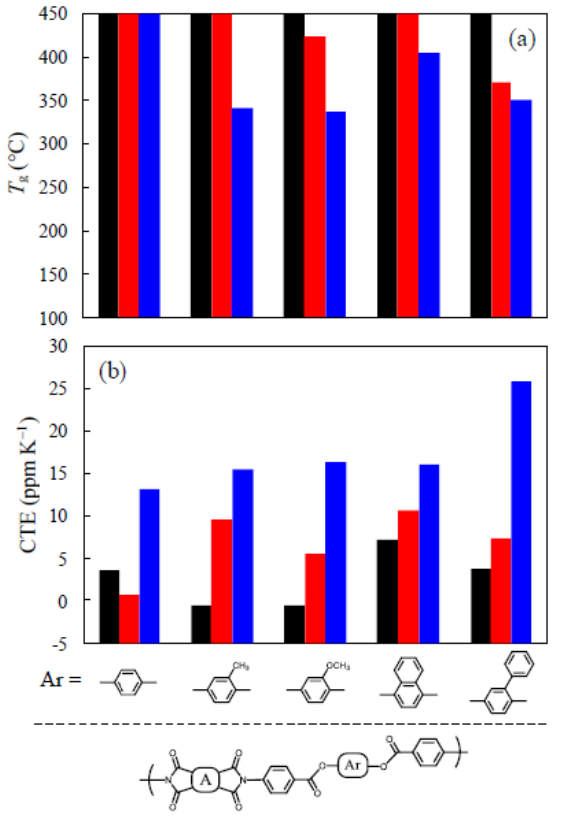
Figure 7. Influence of side group bulkiness on T g ( a ) and CTE ( b ) for PEsIs derived from AB-HQ analogs and different tetracarboxylic dianhydrides: PMDA [left (black) bars], s-BPDA [center (red) bars)], and TA-HQ [right (blue) bars]. When no distinct T g was observed up to 450 °C on DMA, the T g was represented as being higher than 450 °C in this graph.